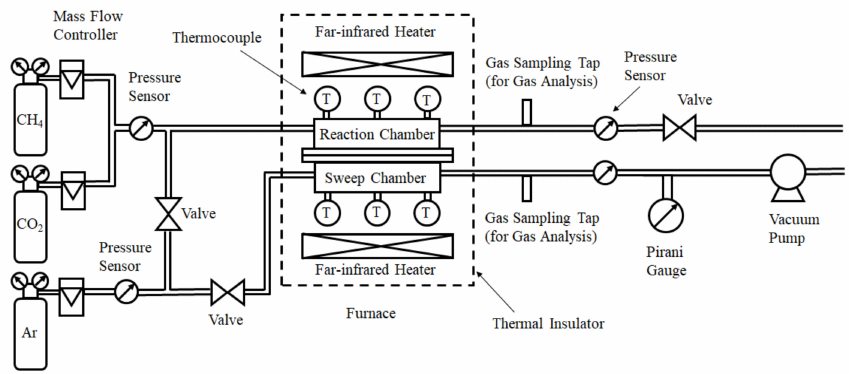
Figure 1. Schematic of experimental